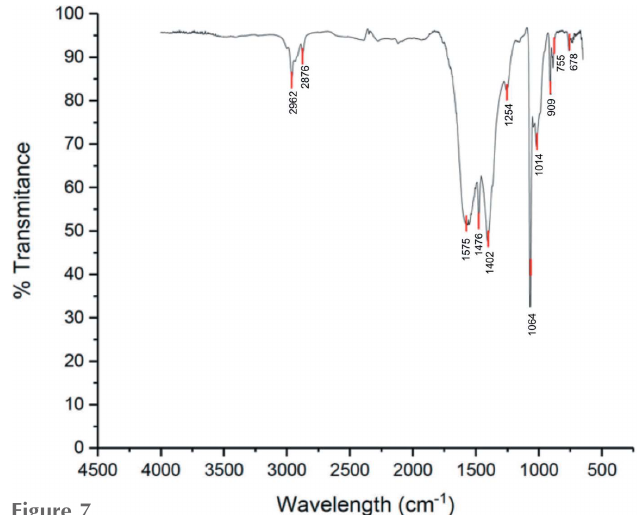
Figure 7 IR spectrum of the title